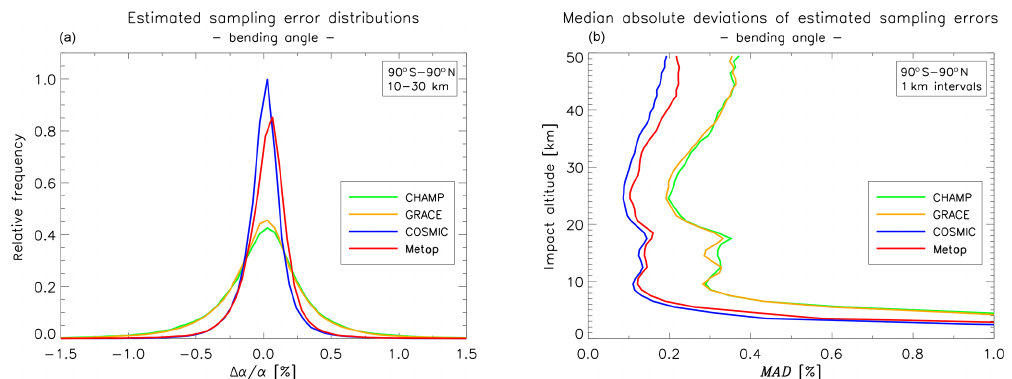
Figure 4. (a) Distributions of estimated bending angle sampling errors based on all monthly bins in the 10–30km height interval, for the four RO missions (CHAMP, GRACE, COSMIC, and Metop). The spread of the distributions, as quantified by the median absolute deviation (MAD), is about 0.3% for CHAMP and GRACE, and 0.1% for COSMIC and Metop. (b) The MADs for height-resolved sampling-error